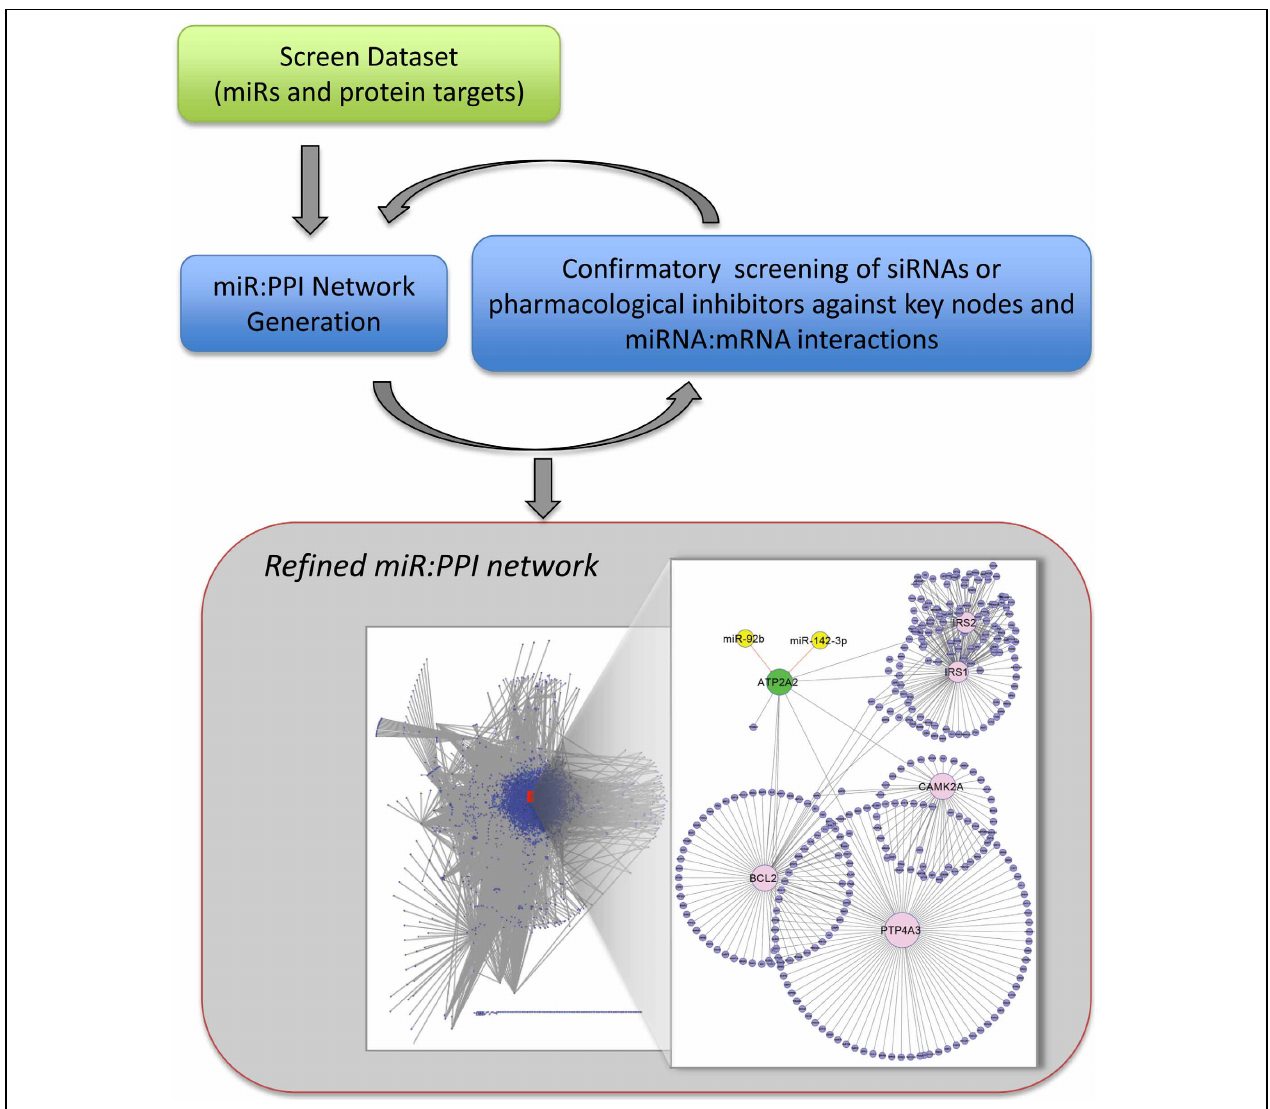
FIGURE 3 | Pipeline for iterative process of network construction and confirmatory screening of key nodes. The screen dataset (as in Figure 1 ) is filtered and used for construction of the preliminary network. We propose that it is beneficial to evaluate individual protein nodes by screening specific si/shRNAs, pharmacological inhibitors or by protein overexpression. Similarly, miR:protein interactions can be validated by monitoring protein levels and direct interaction confirmed by site-directed mutagenesis of the recognition elements in the mRNAs (see text). The